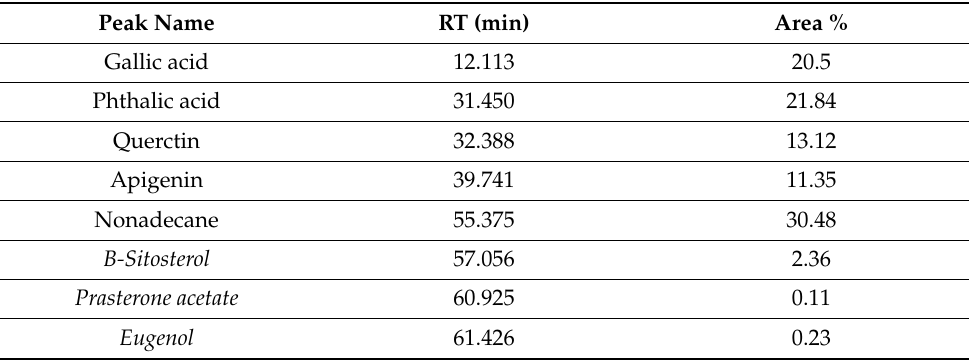
Table 3. Retention time (RT) and peak area (%) of Rosa damascena extract’s main